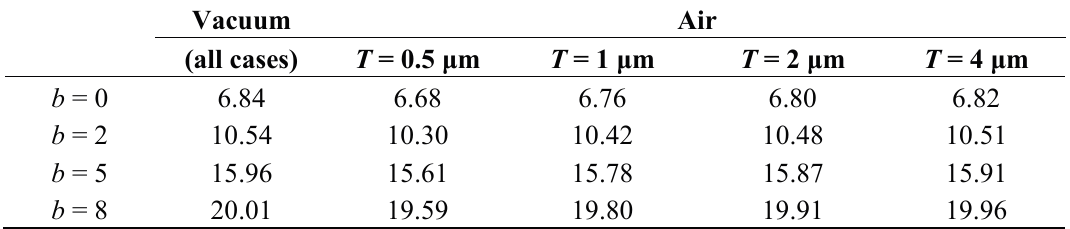
Table 1. The achievable mass sensitivities of the cantilever mass sensors made of silicon with L = 200 μ m, W = 30 μ m, and thicknesses T = 1, 2, and 4 μ m in a vacuum and air-loaded by a mass of ε = 0.01 at h * = 1 as function of an applied axial tensile force.